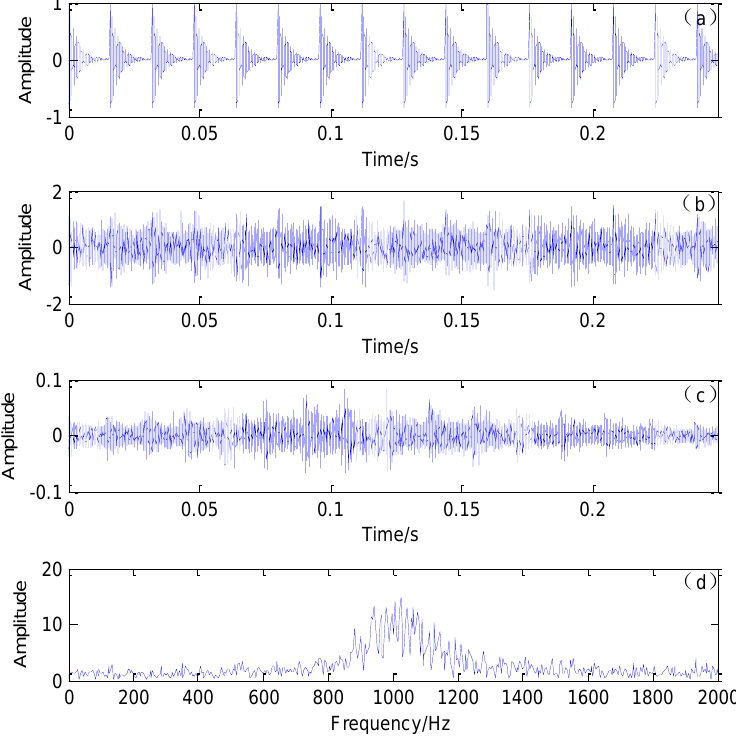
Figure 4. Simulated signals. ( a ) Simulated signal with periodical impacts; ( b ) polluted signal; ( c ) Doppler-distorted signal and ( d ) the Fourier spectrum of the Doppler-distorted